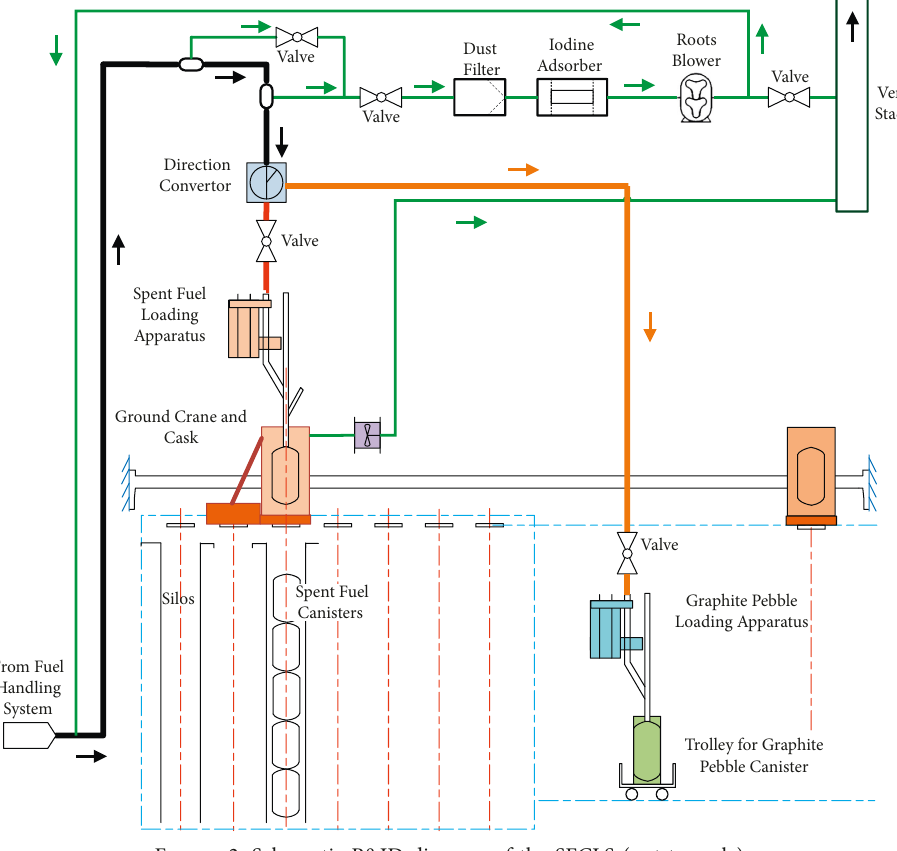
Figure 2: Schematic P&ID diagram of the SFCLS (not to scale).